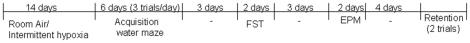
Schematic diagram on the sequence of behavioral experiments and exposures to either IH or RA in both wild type and NADPH oxidase knock-out mice.